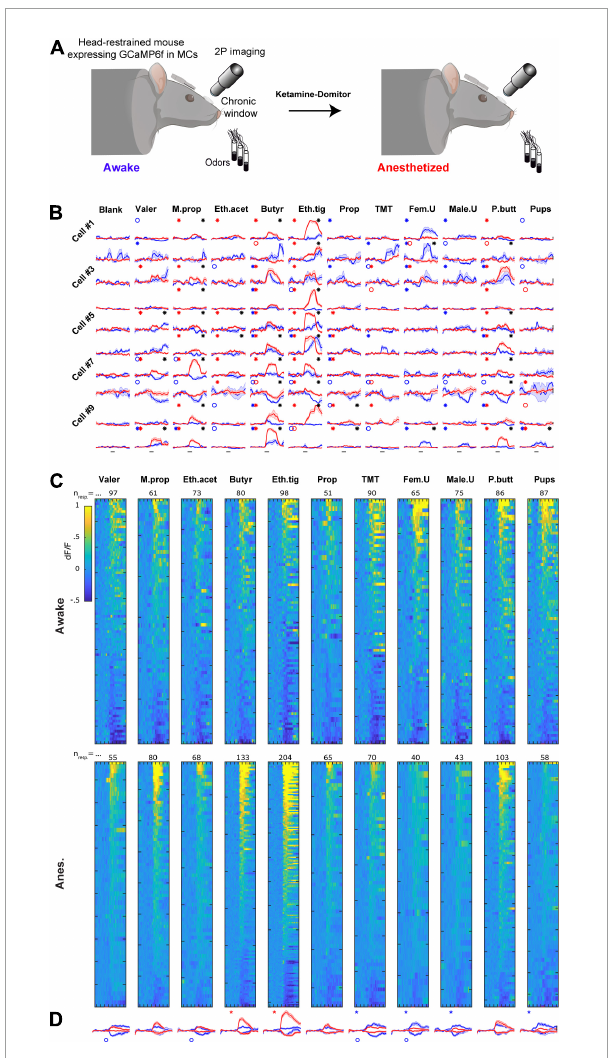
FIGURE4 Imaging the same mitral cells (MCs) in awake and anesthetized states. (A) Schematic illustration of the experiment conducted to follow the same MCs transitioning from awake to the anesthetized state. Created with BioRender.com. (B) Examples of odor-evoked calcium transients before (blue) and after (red) anesthesia from 10 neurons in response to 11 odors. Odor stimulation is denoted as a black horizontal line bellow all traces (2 s). Traces are mean + - SEM calculated over five single trials for each time point. Blue/red asterisks denote significant E responses and blue/red circles denote significant S response in awake or anesthetized sessions, respectively. Black asterisks mark a statistically significant difference between conditions. Scale – vertical black lines, 30% dF/F. (C) Significant odor responses of all neurons, sorted by response magnitude. Responses were recorded from the same MCs in either awake (top) or anesthetized (bottom) sessions. The total number of responses per stimulus is depicted above each column. Odor presentation (2 s) is marked by a red line at the bottom of each column. (D) Average traces of S and E responses for each one of the odors presented in awake (blue) and anesthetized (red) sessions (mean + - SEM). Responses are depicted in a paired manner (see section “Materials and methods”). Scale – vertical black line, 20% dF/F. Each trace represents 7 s pre-stimulus, 2 s stimulus presentation, and 7 s